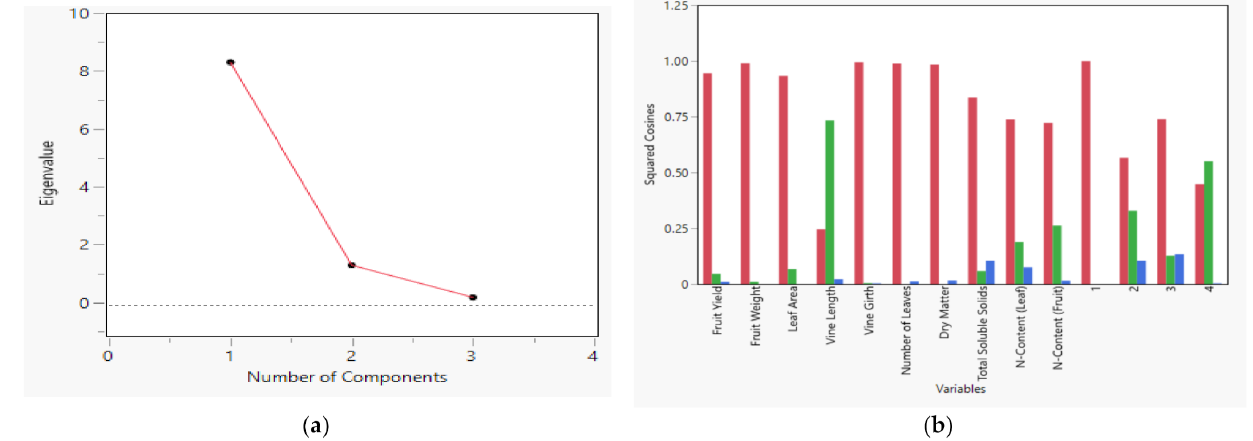
Figure 5. ( a ) Scree plot reveals the number of components covering sufficient variation related to treatments used for inves- tigated traits. ( b ) Squared cosines associated with the principal components for ten investigated traits and four treatments.